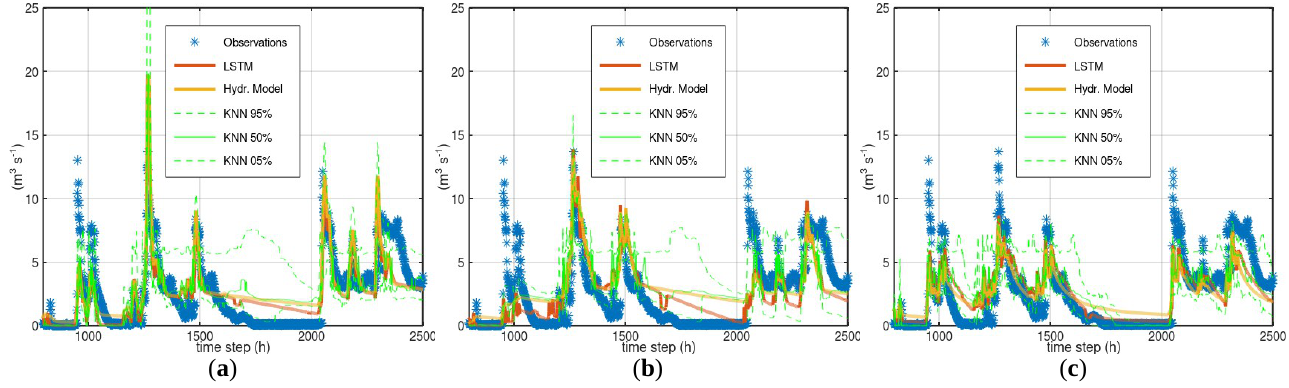
Figure 10. Simulation of Bakas River, for time steps 800–2500 of test period: ( a ) HYMOD (note the CI width around time step 1800 and the upward step of the lower limit right after); ( b ) LRHM (note the increase in CI width between time steps 2000–2500 during low flows); and ( c ) GR4H (note the “preference” of the upper limit for a specific value (around 6 m 3